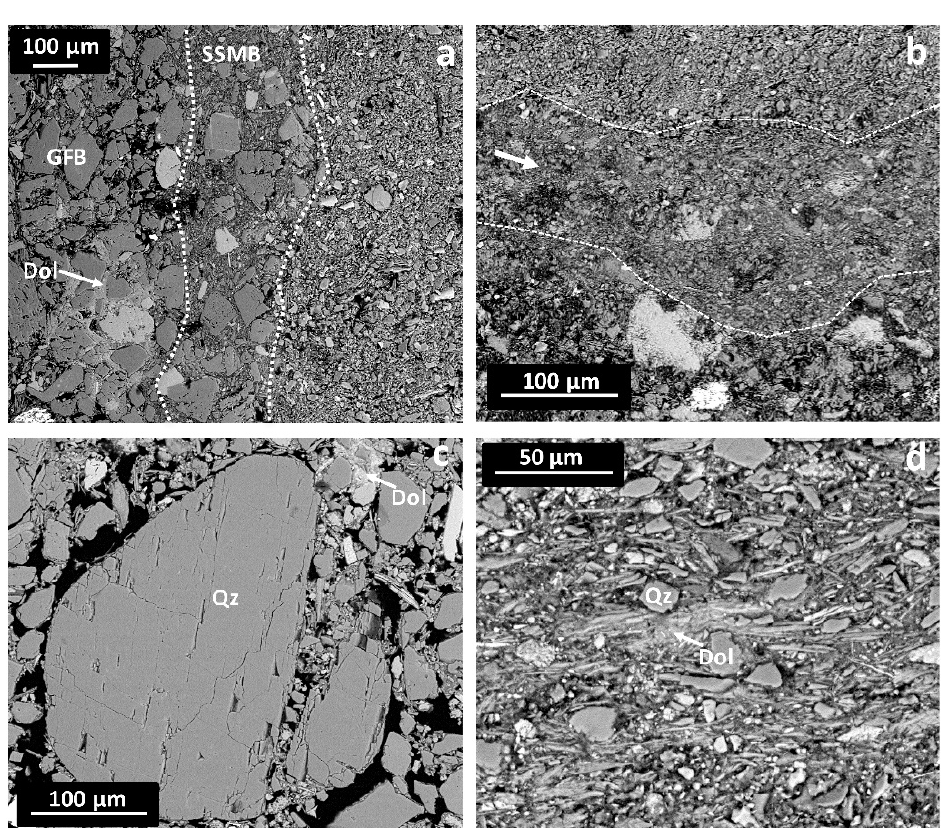
Figure 6. BSE images of silt sediments. ( a – c ) Disaggregation bands. Quartz and feldspars are the dominant grains of these bands. ( d ) Phyllosilicate band. Muscovite, paragonite, chlorite (brighter grains) are the predominant platy minerals. Angular grains are mainly quartz. Dol: dolomite, Qz: quartz, GFB: granular flow band, SSMB: mixing with sediments of smaller size band. The arrow in ( b ) indicates a band with smaller grain size. Black areas are pores.